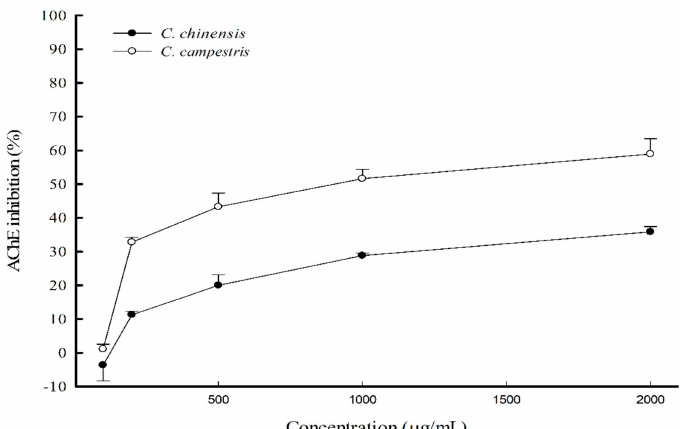
Figure 8. The acetylcholinesterase (AChE)-inhibiting effects of Cuscuta chinensis and C. campestris extracts in vitro. The supernatants of the brain homogenates were used as the AChE source for the assay. Four concentrations of the C. chinensis or C. campestris extract (0.5, 1, 1.5, and 2 mg/mL) were used to examine their inhibitory activities. Data are expressed as mean ± SD ( n =